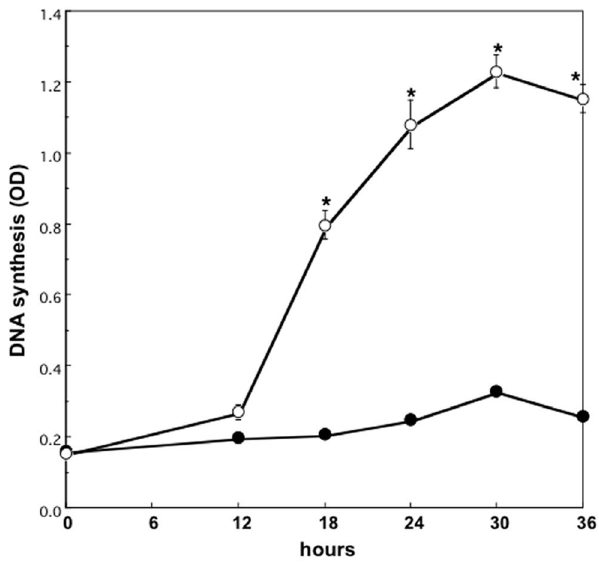
Figure 1. Changes in DNA synthesis of hepatocytes after HGF treatment. Rat hepatocytes were cultured in WE containing 10% FCS, 10 ng/mL HGF and 0.1 mmol/L BrdU, and were harvested serially. Closed circles denote hepatocytes cultured at high density. Open circles denote hepatocytes cultured at low density. Data are mean 6 SEM of eight dishes. *p , 0.01 compared with the values cultured for 0 hours.